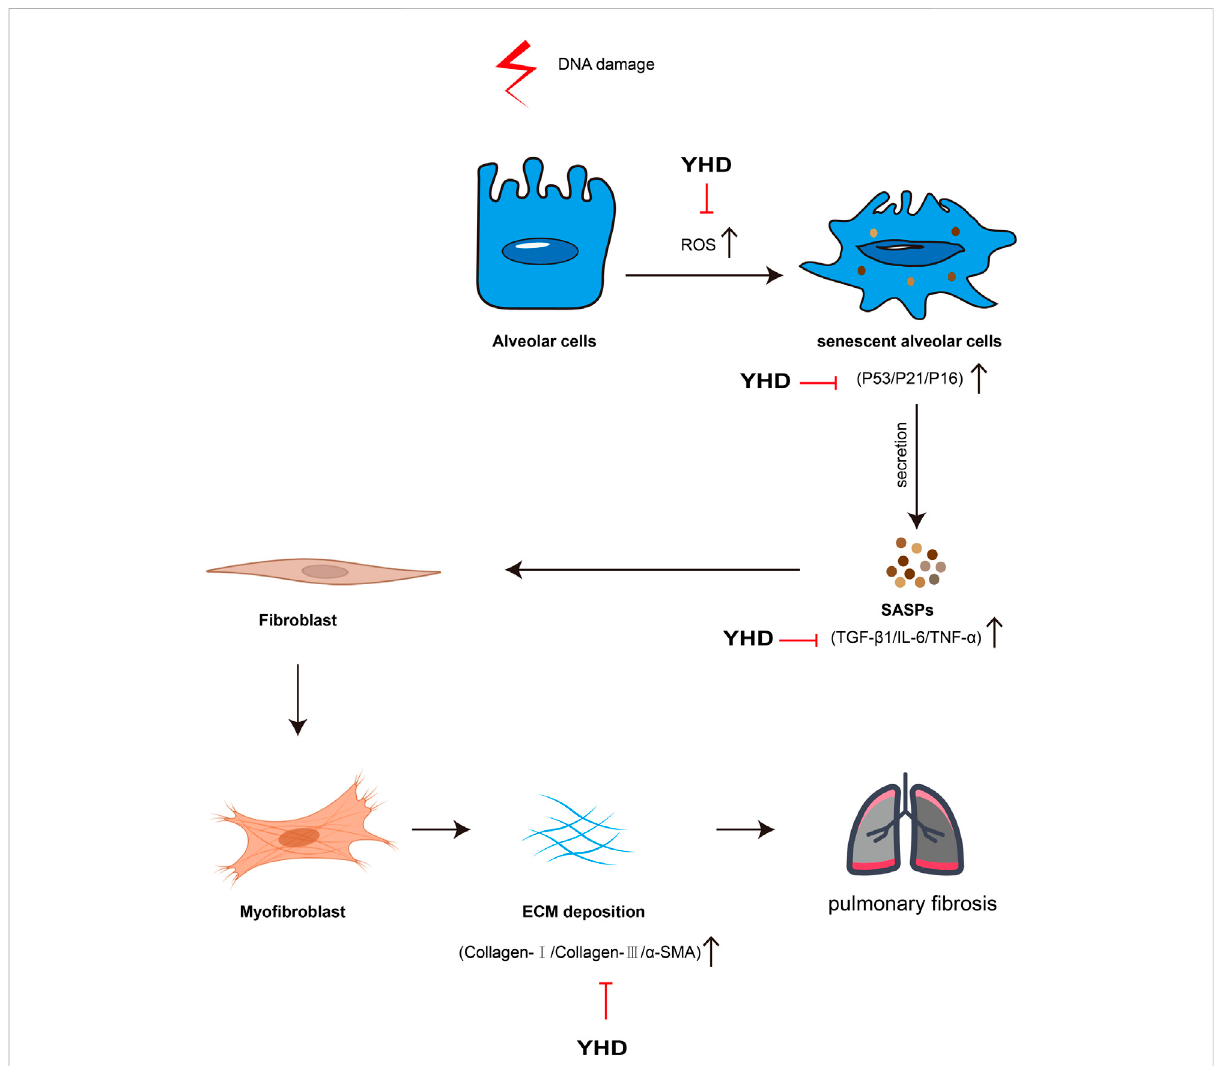
FIGURE 9 Schematic of Mechanism of YHD in treating PF. The red arrows indicate inhibitory